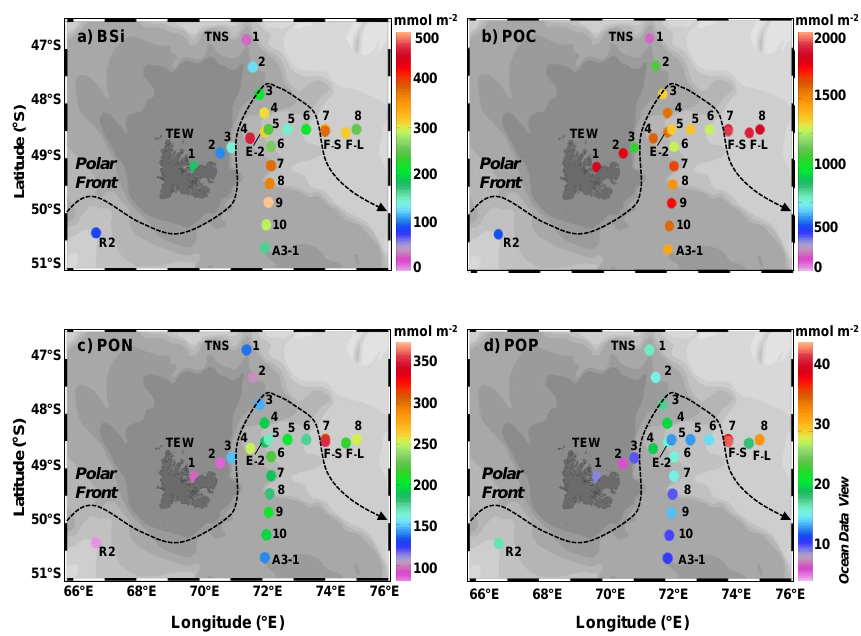
Figure 8. Figure 8. Distribution of biogenic silica (a) , particulate organic carbon (b) , nitrogen, (c) and phosphorus (d) (same vertical integrations and legends as Fig.